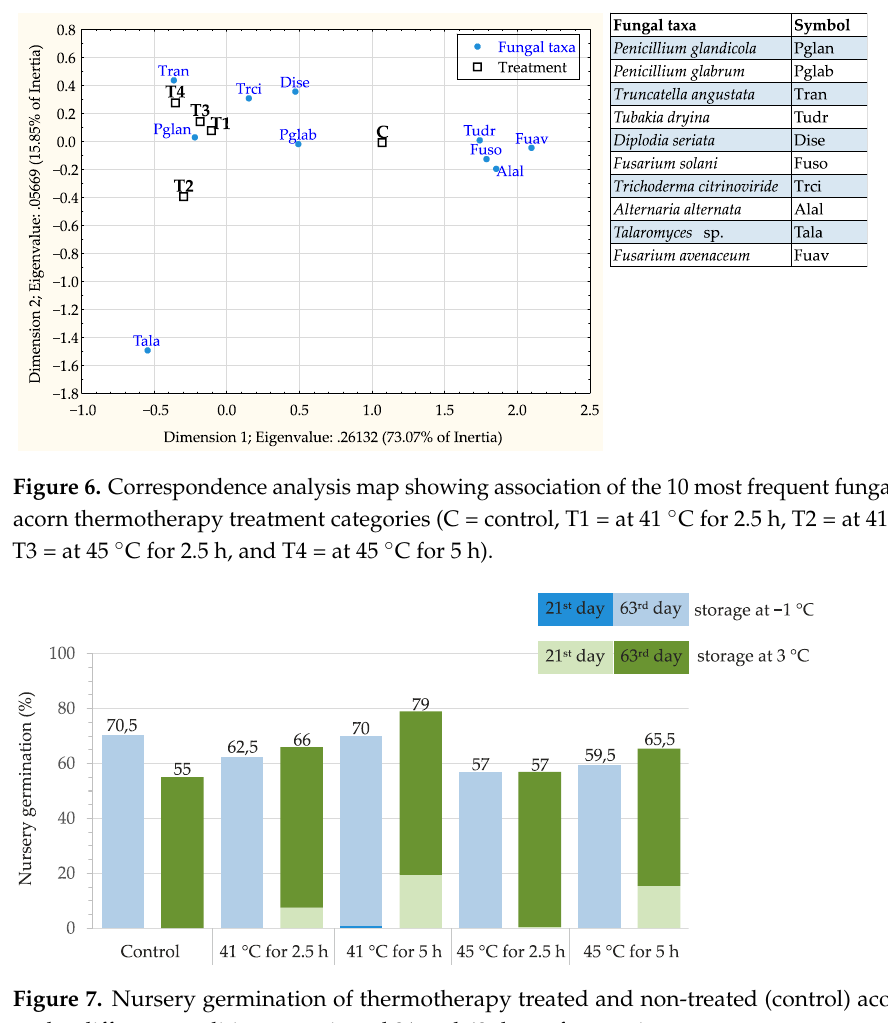
Table 2. Pearson correlation coefficients and related p values reveal no significant correlation between the number of obtained isolates of the eight most frequent fungal species and acorn germination in groups sown in a nursery trial. Figure 7. Nursery germination of thermotherapy treated and non-treated (control) acorns stored under different conditions, monitored 21 and 63 days after sowing.